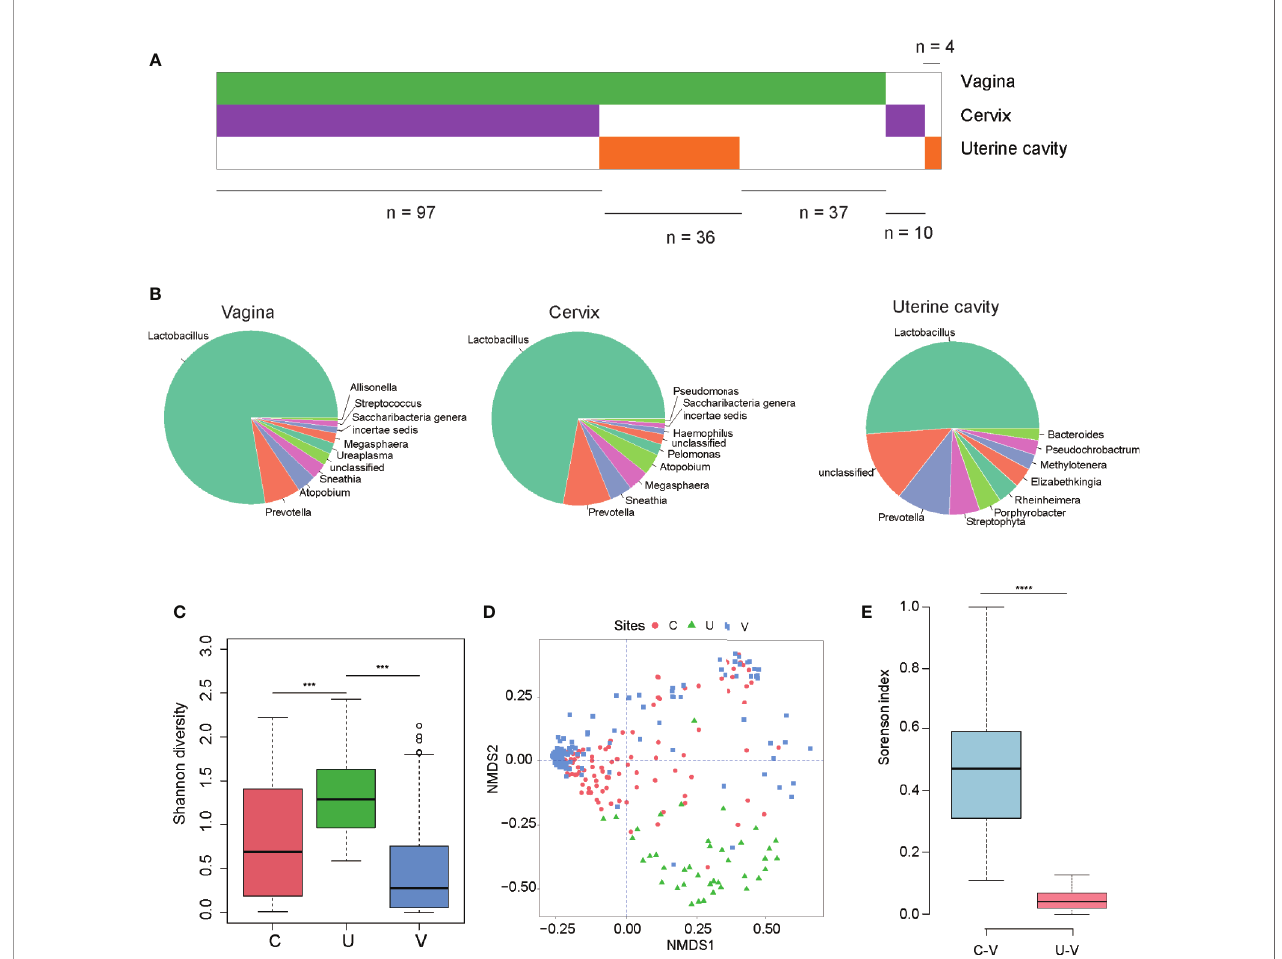
FIGURE 1 | Microbiome landscape in the genital tract of reproductive-aged women. (A) An overview of the sample collections (97 paired vagina – cervix samples and 36 paired vagina – uterine cavity samples). (B) Pie chart for 10 genera with the highest abundance at each site according to the mean relative abundance. (C) The Shannon diversity among the three sites of female genital tract (FGT). (D) Comparison of community for non-metric dimensional scaling (NMDS) ordination of the Bray – Curtis distance between sampling sites (V, vagina; C, cervix; U, uterine). (E) Intraindividual similarity between vagina – cervix and vagina – uterine. ***P-value < 0.001, ****P-value <